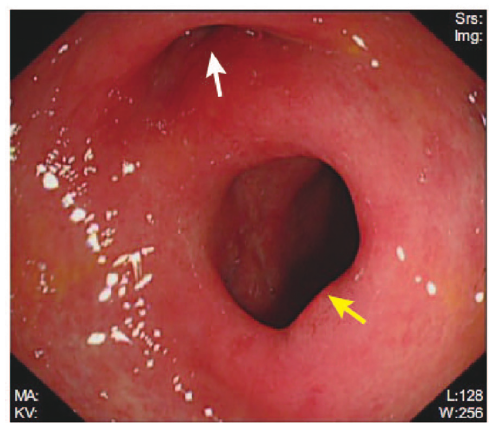
Figure 2 Gastroduodenoscopy. Image showing the opening (white arrow) of the fistula in the lesser curvature of the stomach and pylorus (yellow arrow).